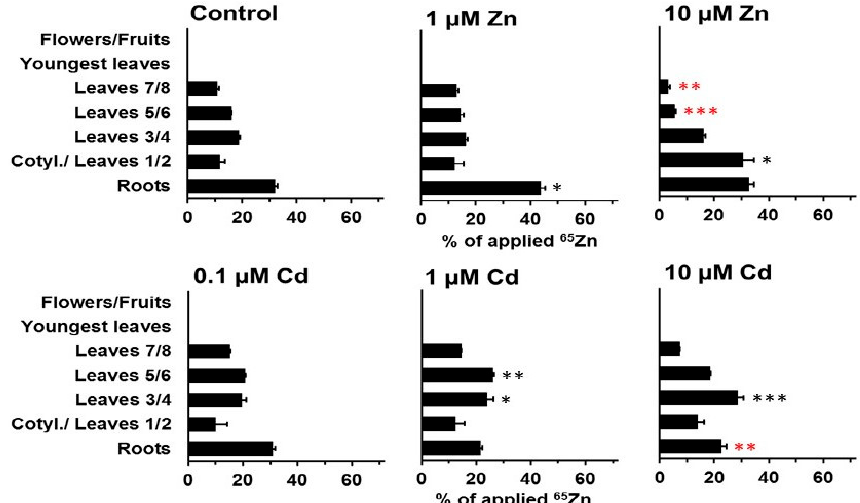
Figure 6. Redistribution of 65 Zn in plants grown on standard nutrient medium (Control) or on the same medium with increased Zn (1 µM Zn and 10 µM Zn) or Cd (0.1 µM Cd, 1 µM Cd, and 10 µM Cd) concentrations during 11 d after the labeling phase (duration: 3 d). Means + SE of four replicates are shown. Significantly higher (*, **, ***) and lower (*, **, ***) values than in control plants on the P=0.05 (*, *), P=0.01 (**, **) and P=0.001 (***, ***) level are indicated (Student’s t-test).